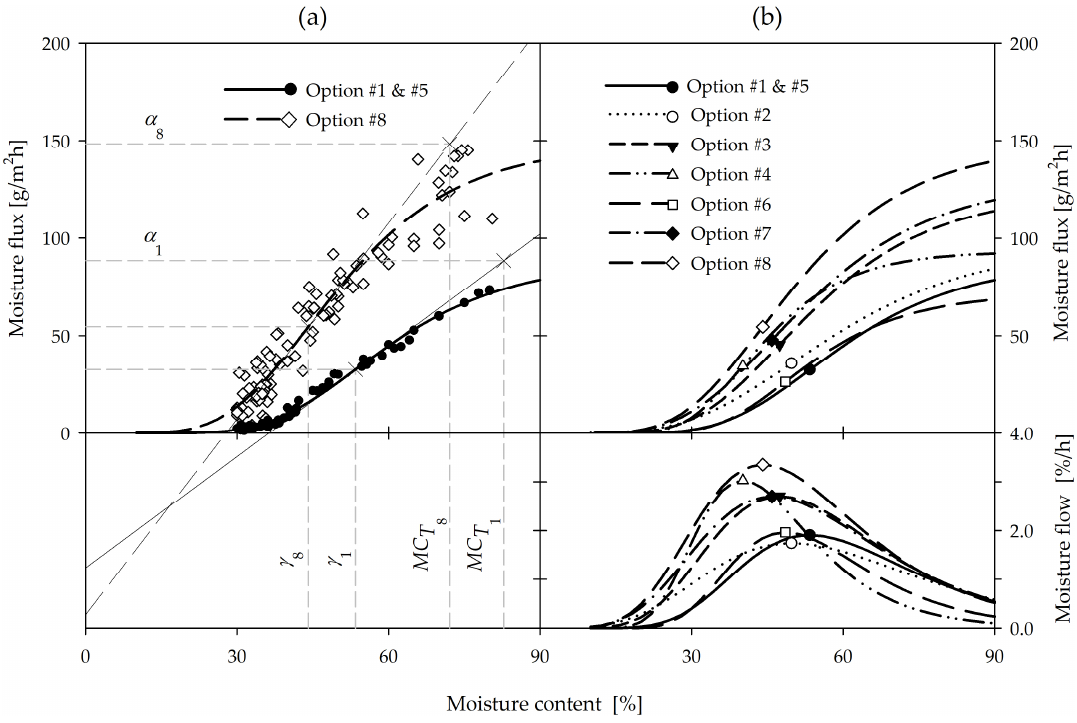
Figure 3. Moisture flux changes with moisture content (upper plots) for the most intensive oscillation- and reference-drying schedules ( a ) as well as all analyzed schedules ( b ) together with moisture flow (bottom right plot).